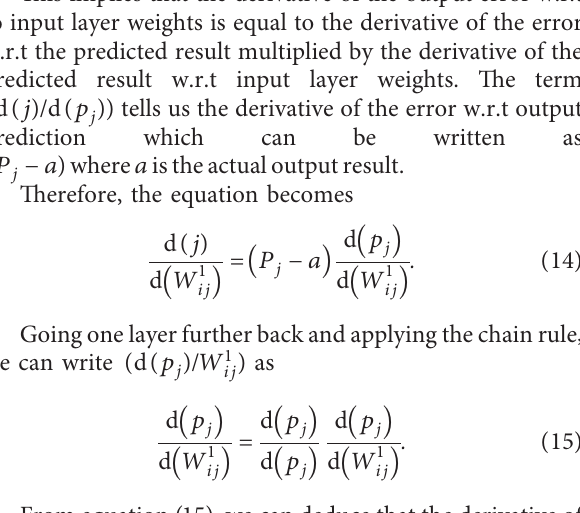
Figure 7. The architecture of the learner model in Figure 7 is simplified for a better understanding of the backpropagation process. Mathematically, we are trying to obtain how